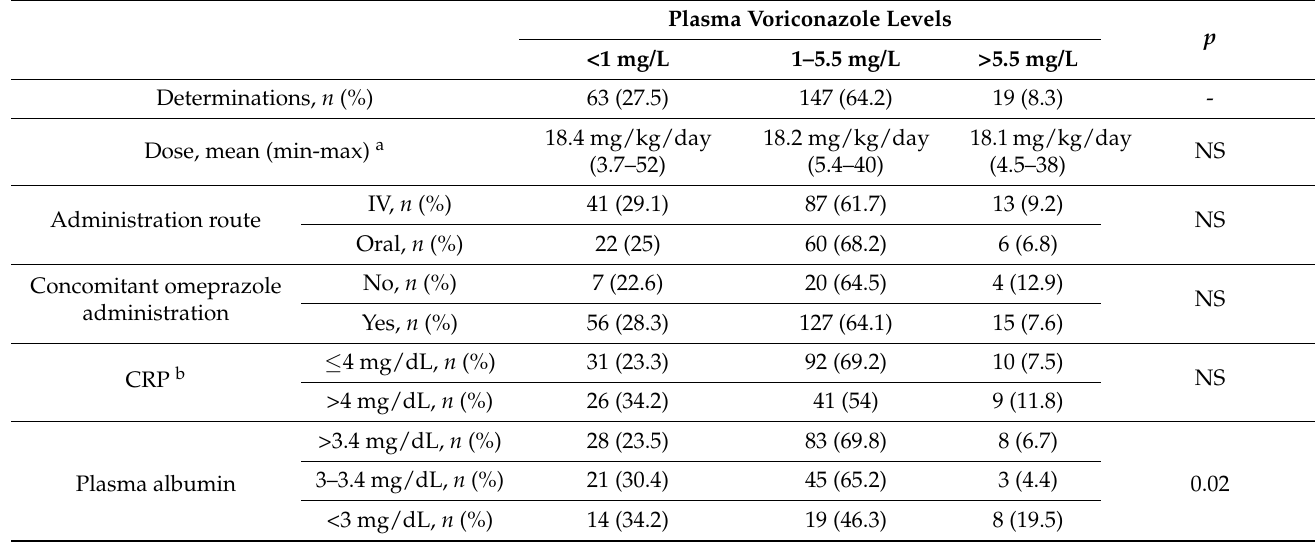
Table 3. Analysis of plasma voriconazole levels during treatment.